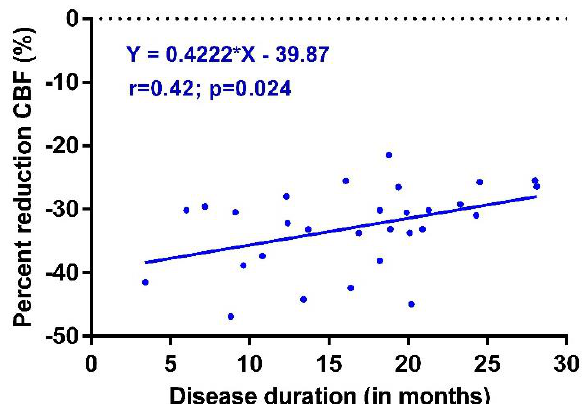
Figure 3. Cerebral blood flow reduction in long-haul COVID-19 patients with POTS, with OH, and with a normal heart rate and blood pressure during the tilt test. CBF: cerebral blood flow; OH: orthostatic hypotension; normHRBP: normal heart rate and blood pressure response during the tilt test.